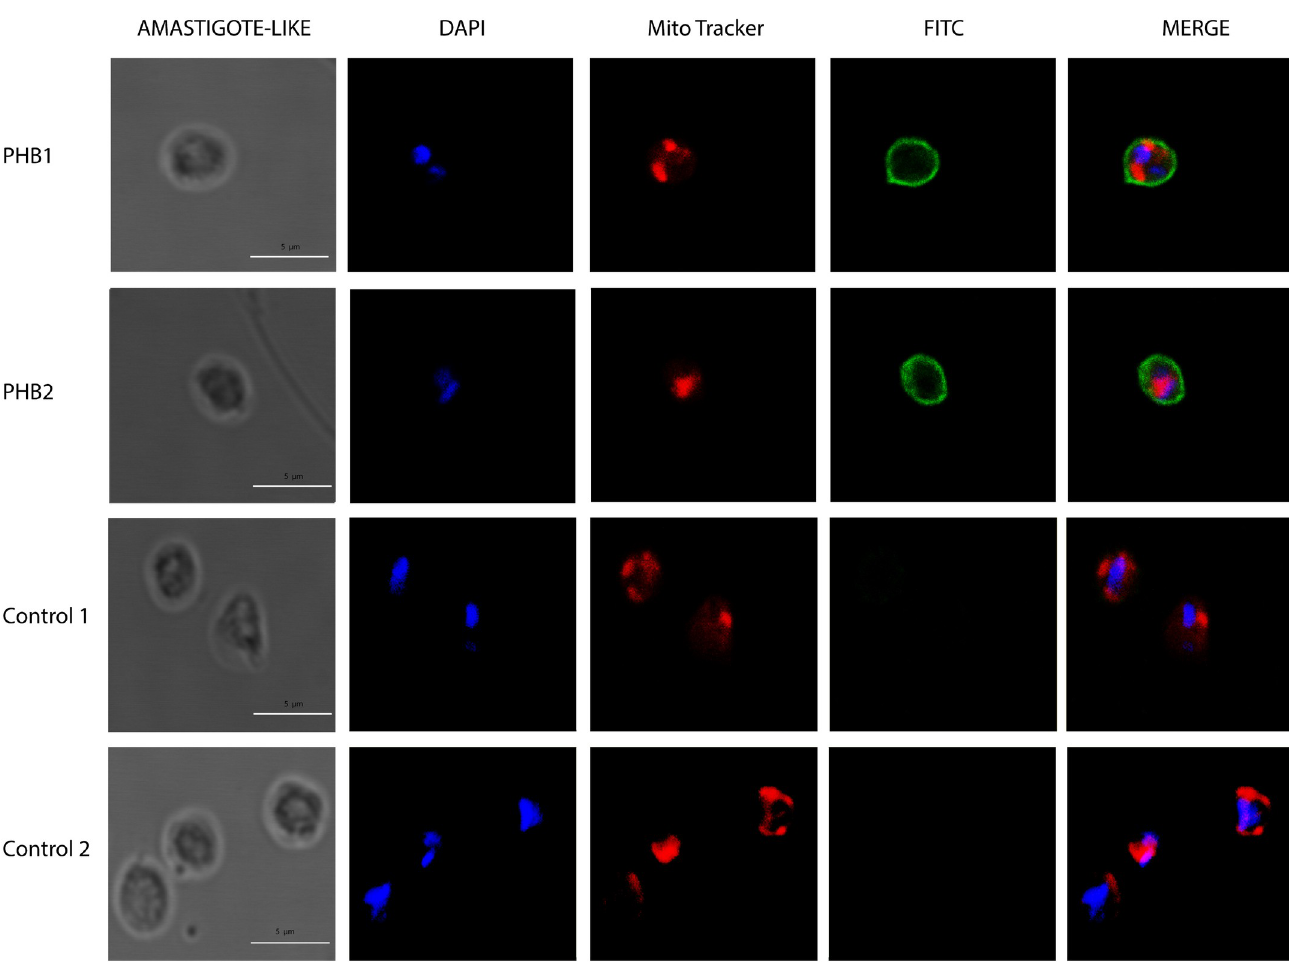
Fig 4. Fluorescence microscopy analysis in amastigote forms of PHB1 and PHB2 using antibodies produced against T . cruzi PHB recombinant proteins. In blue, DAPI-labeled DNA; in red, the mitochondria labeled with MitoTracker; in green, PHB1 and PHB2 detected with FITC-conjugated secondary antibody. The merged images show the overlap of the green, red and blue